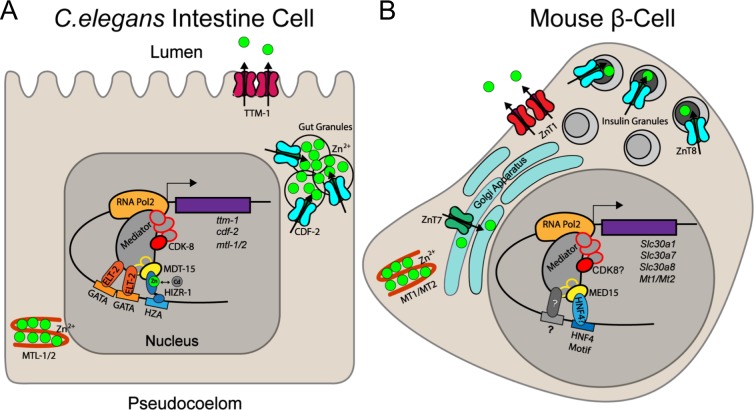
Model of MDT-15 and MED15 driven gene regulation in response to cadmium or high levels of zinc.[A] In the C. elegans intestinal cells, MDT-15 cooperates with HIZR-1 bound to the HZA element to induce the metal-sequestering metallothioneins (mtl-1 and -2) and the transporter cdf-2, which shuttles zinc into storage granules; excess cadmium is likely detoxified through similar mechanisms. ELT-2 may also contact Mediator to regulate cadmium or zinc responsive transcription. [B] In the mouse pancreatic β-cells, Med15 regulates the expression of genes such as Slc30a8/ZnT8 in response to elevated zinc levels, possibly via HNF4, or other, Mediator contacting transcription factors.